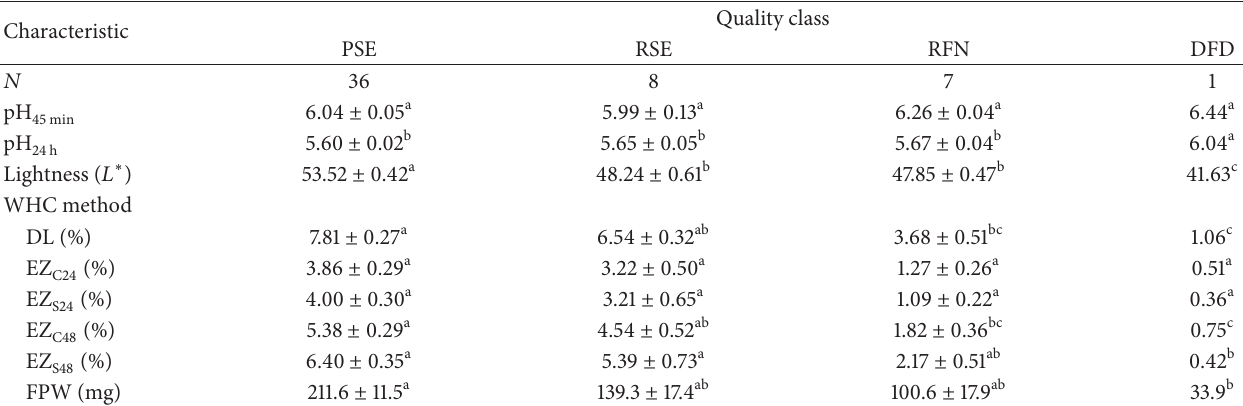
Table 3: Meat quality characteristics (mean ± standard error) of four quality groups by Warner et al. [12] criteria of pork loin ( Longissimus thoracis muscle; n = 52) 1